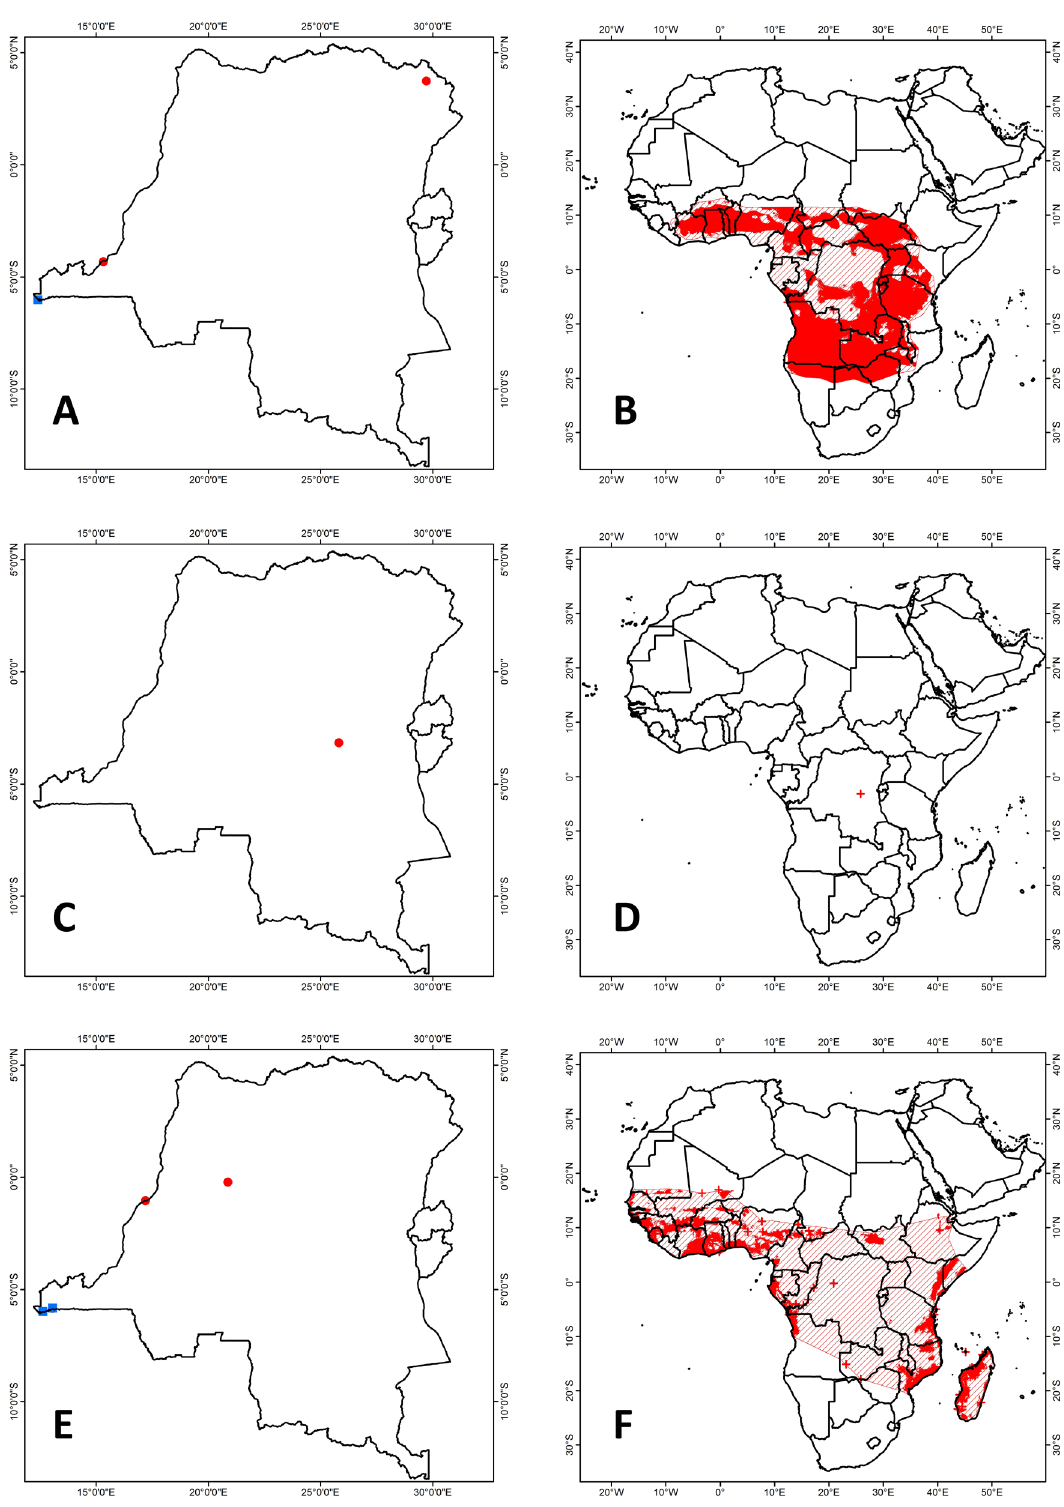
Fig. 25. Distribution maps. A–B . Chaerephon chapini J.A. Allen, 1917. C–D . Chaerephon gallagheri (Harrison, 1975). E–F . Chaerephon leucogaster (A. Grandidier, 1869). A, C, E. Distribution in the